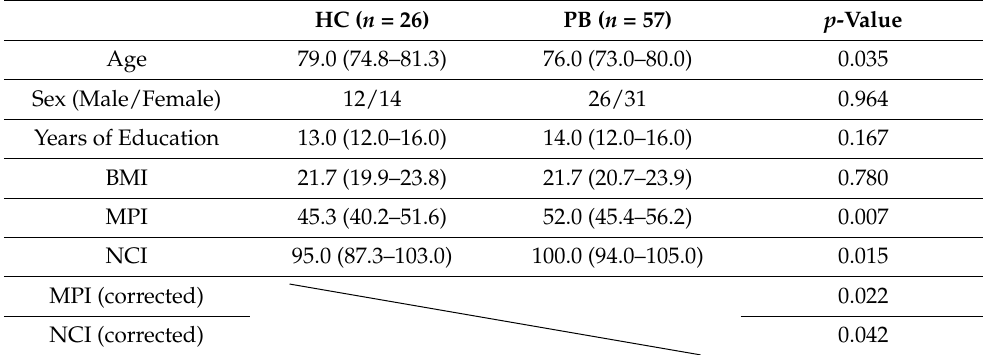
Table 7. Cohort B (CNS) characteristics classified by the discriminant analysis